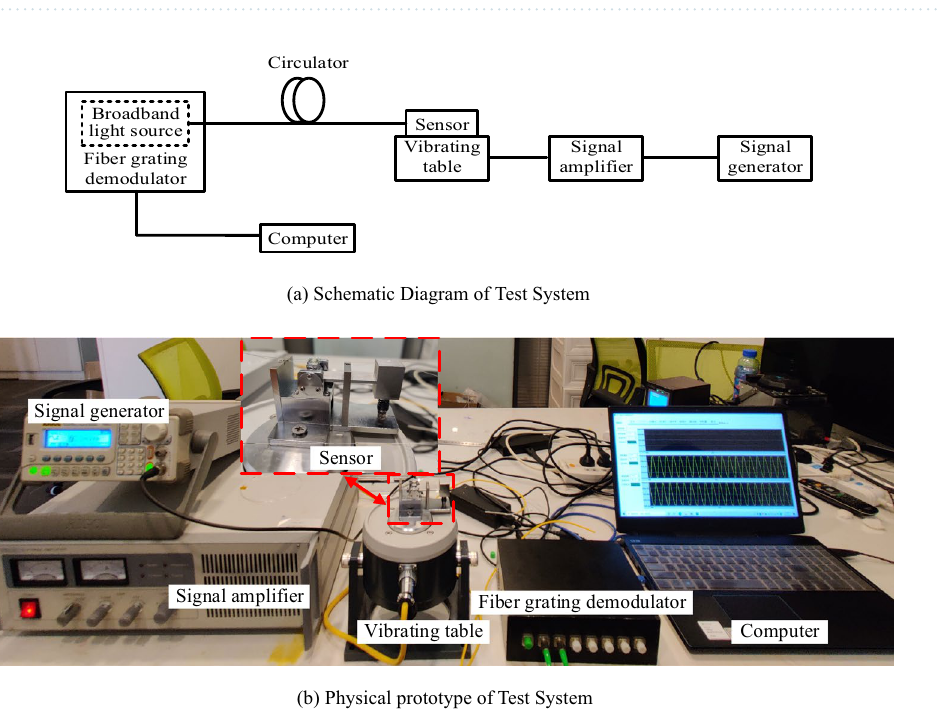
Figure 9. Test system of the